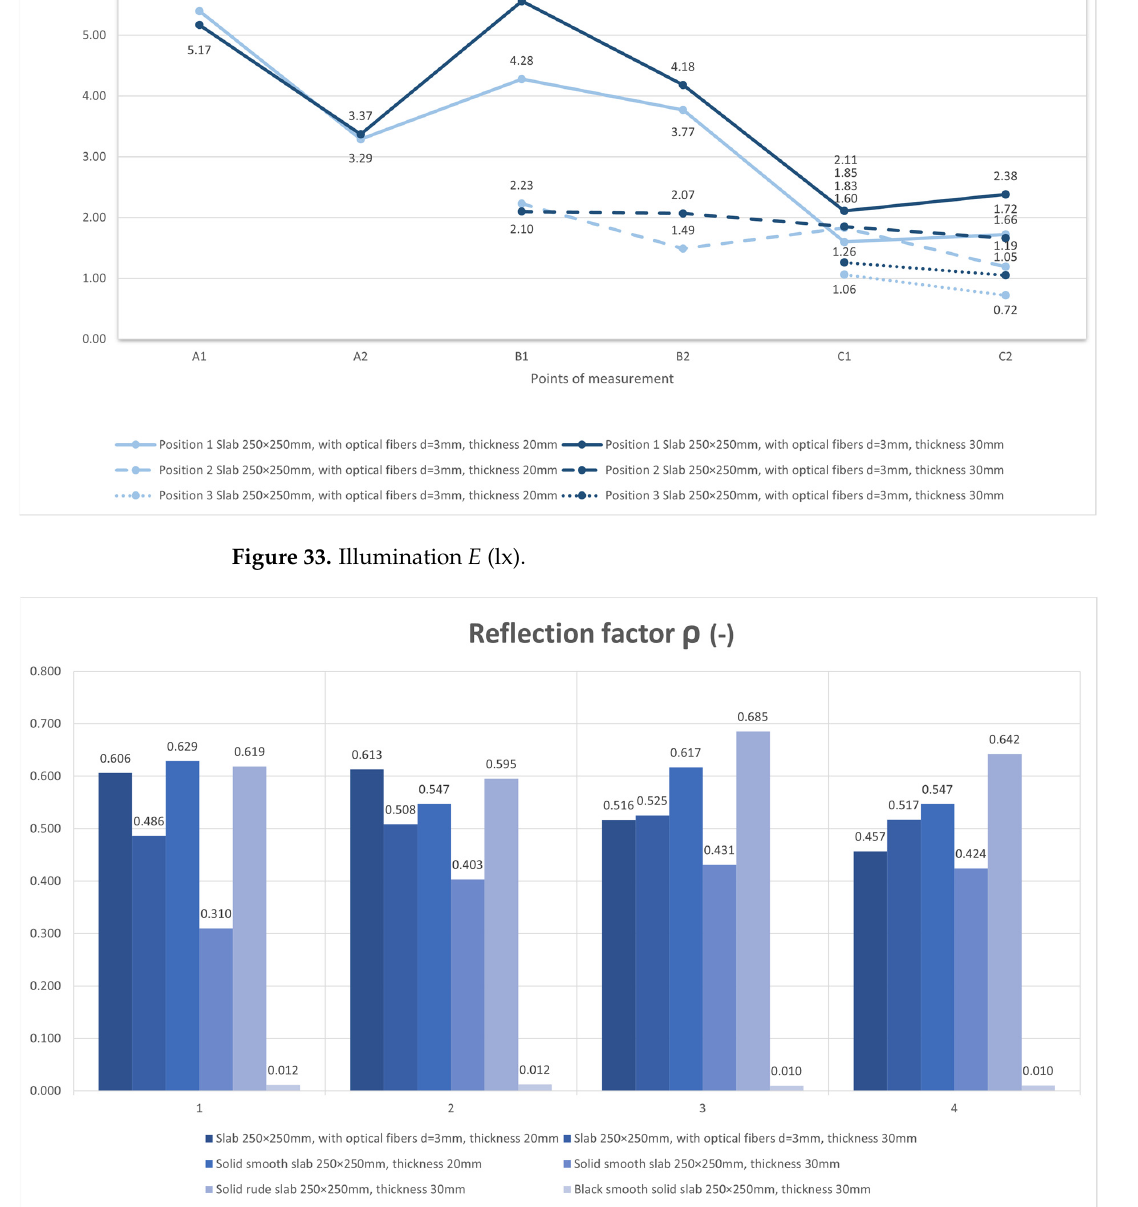
Figure 34. Reflection factor ρ (-). Table 8. Illumination E (lx)—Part 1.